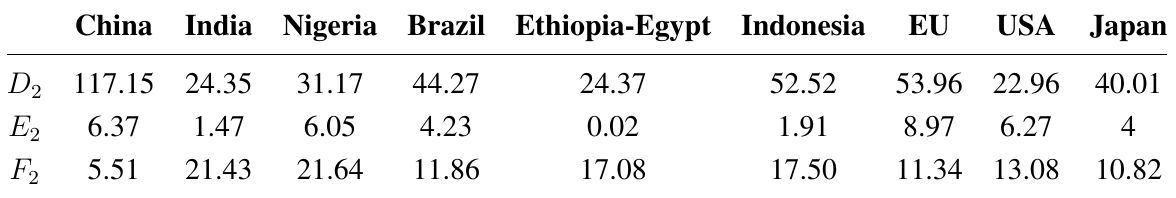
Table 5. Timescales (in Years) for exponential